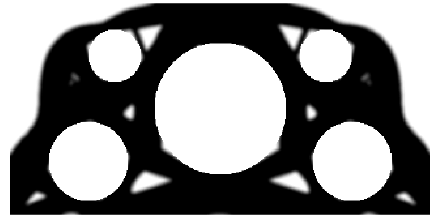
Figure 37. Iteration history for the structure under two-load case. Figure 34. The final topology obtained using [35]. Figure 34. The final topology obtained using [35]. Figure 34. The final topology obtained using [35].